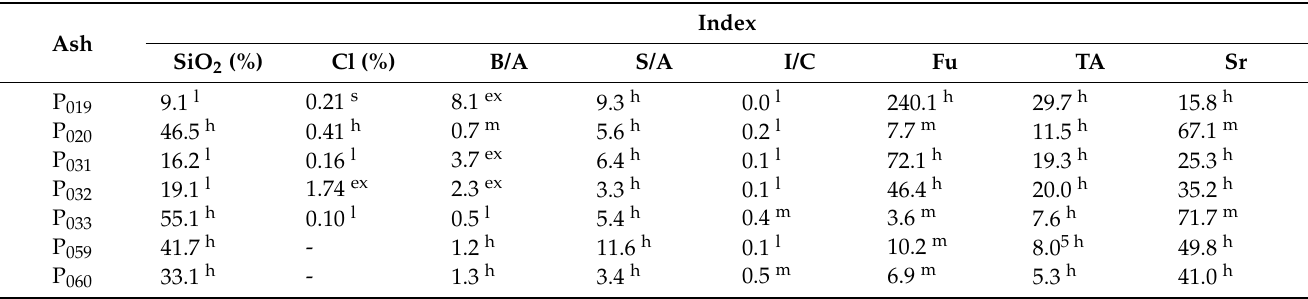
Table 6. Calculation of slagging and fouling indices for individual ash